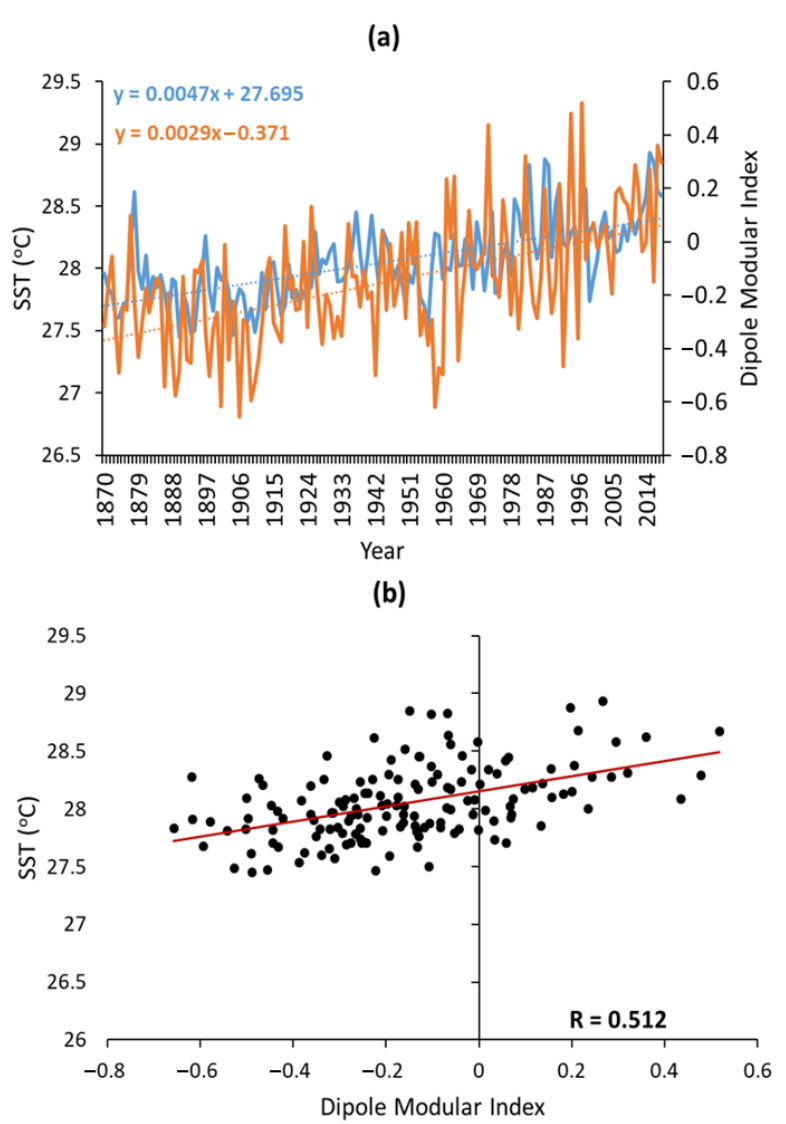
Figure 12. ( a ) SST and dipole mode index (DMI) variability and ( b ) correlation between SST and DMI throughout the study period.